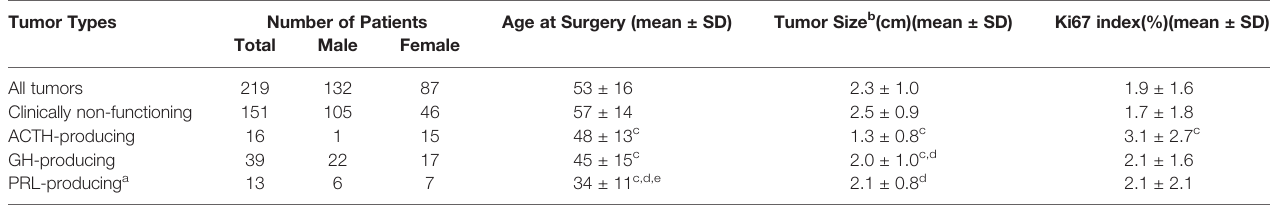
TABLE 1 | Clinical